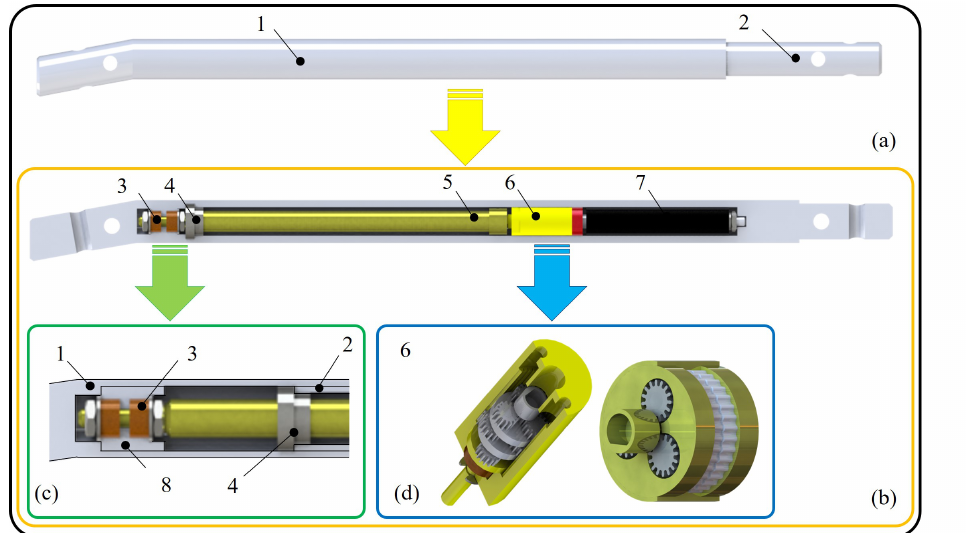
Figure 3. Prototype of ISDR implantable lengthening nail. 1—protective shell, 2—distraction nail, 3—thrust bearing, 4—lead screw nut, 5—lead screw, 6—gearbox, 7—internal permanent magnet,